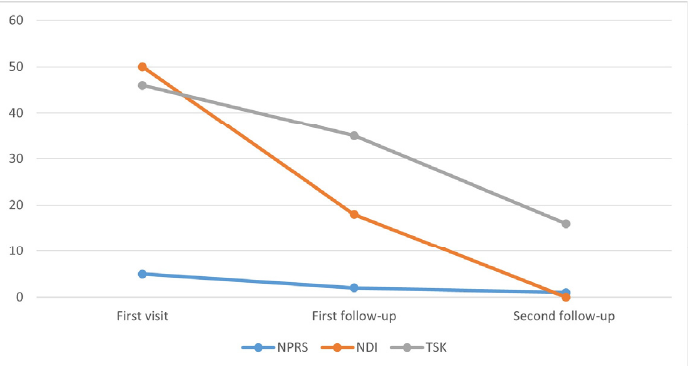
Figure 4. PROMs scores during the treatment—NPRS (numeric rating pain scale) scores from 0 to 10; NDI (neck disability index) scores from 0 to 50; TSK (Tampa scale of kinesiophobia) scores from 13 to 52.